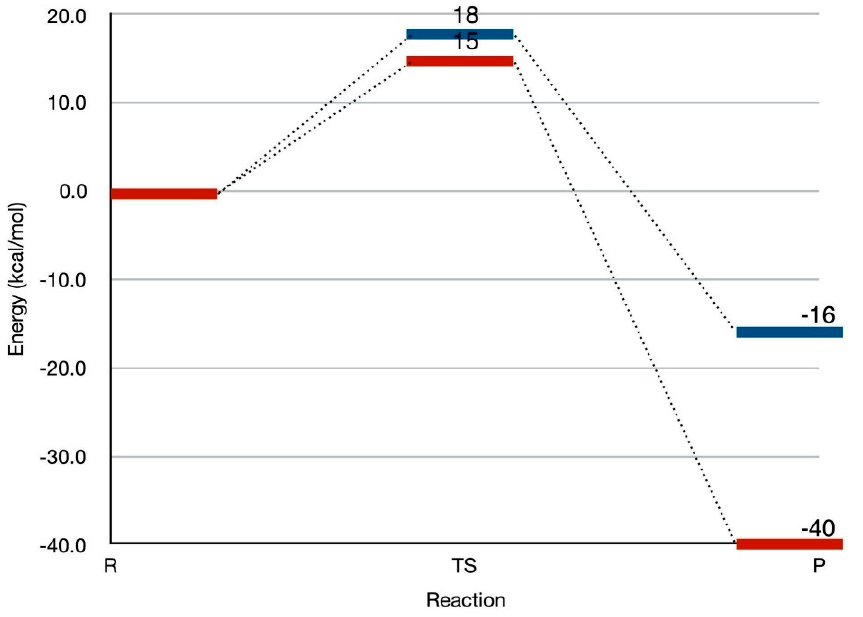
Figure 5. Comparison of energy profile for each tested hypothesis ( The Neutral His405 System ( − ) and The Cationic His405 System ( − )).